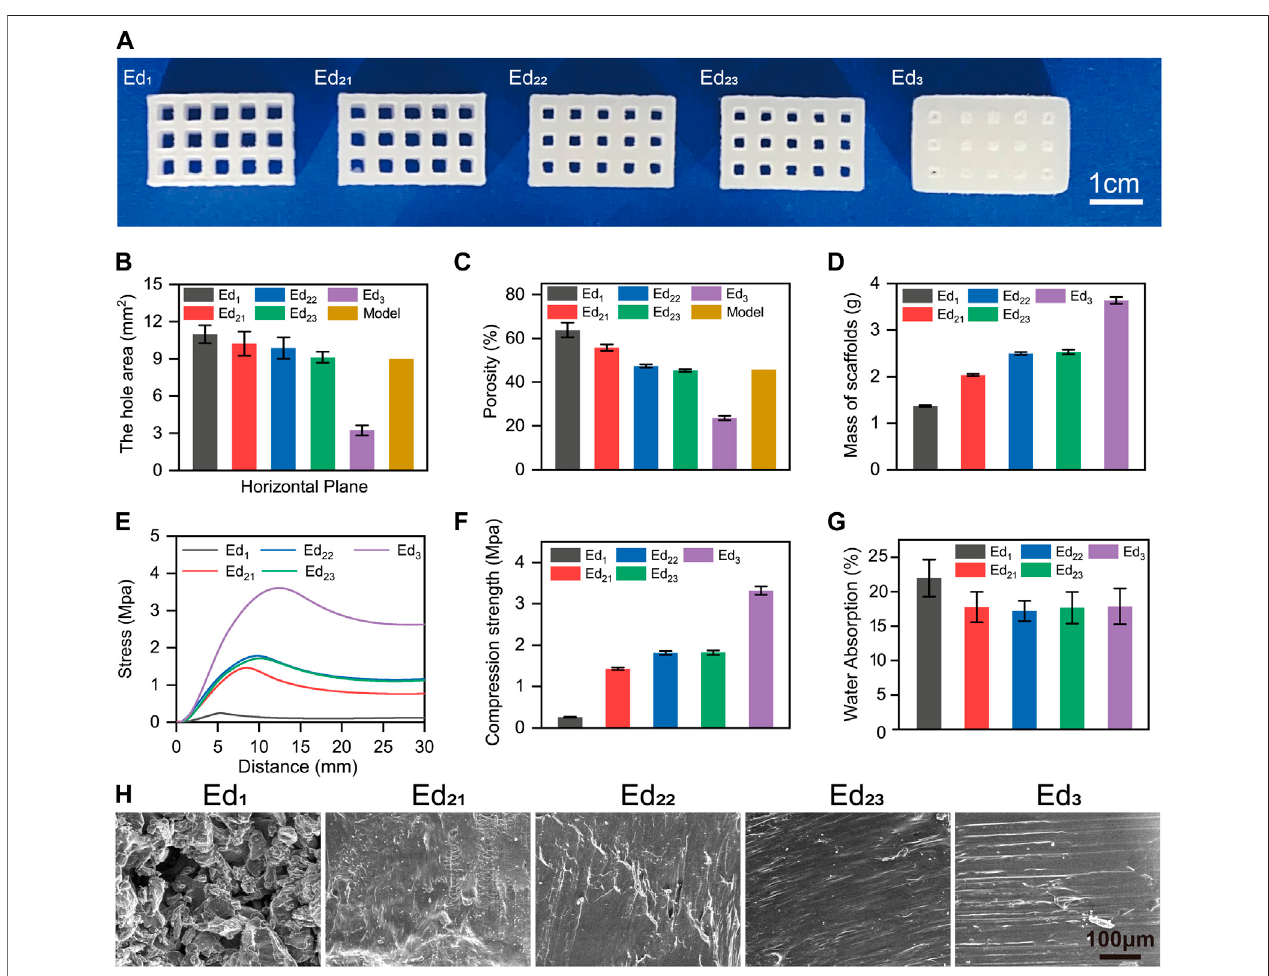
FIGURE 4 | Characterizations of fi ve kinds PCL scaffolds with different SLS parameters. (A) Photo of SLS-fabricated PCL scaffolds, (B) horizontal pore area, (C) porosity, (D) mass, (E) stress – strain curves, (F) maximum compressive strength, (G) water absorption, and (H) cross-section SEM images of scaffolds.